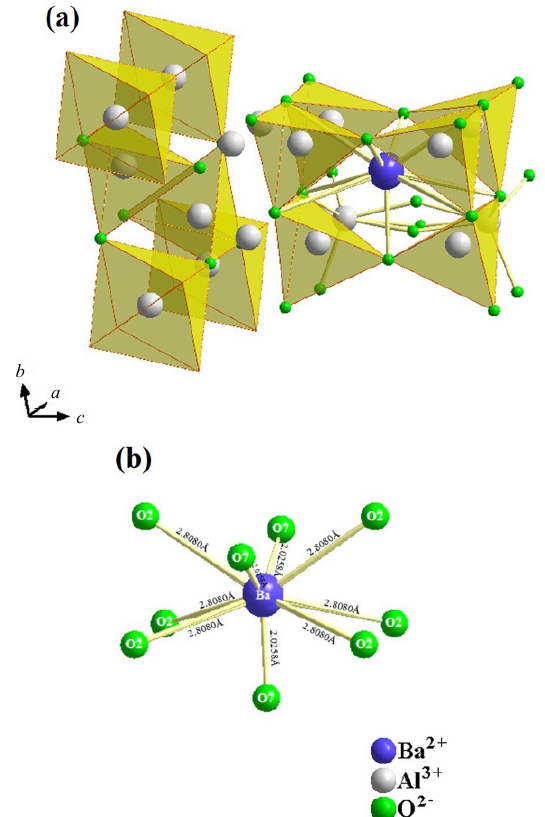
Fig. 2 Crystal structures of Ba 0.79 Al 10.9 O 17.14 .